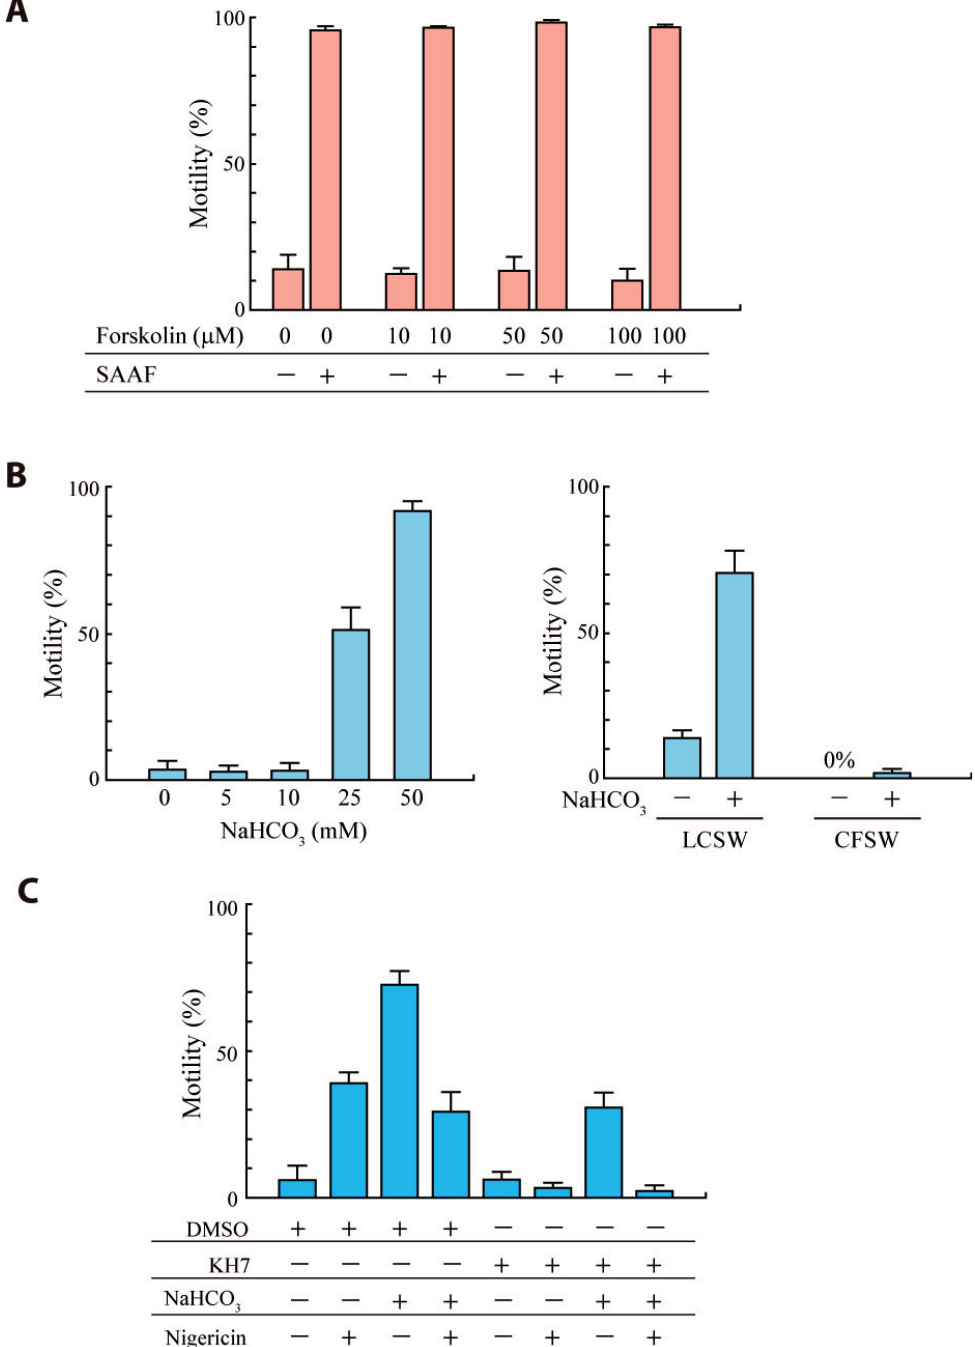
Figure 5. Effects of AC activators on activation of Ciona sperm motility. The percentage of motile sperm was measured 3 min ( A ) or 1 min ( B , C ) after the addition of sperm to the solutions containing forskolin ( A ), NaHCO ( B , C ) with or without sAC inhibitors. 3 The concentration of KH-7 or nigericin was 10 or 5 μ M, respectively. Values are means ± SE of the results from three